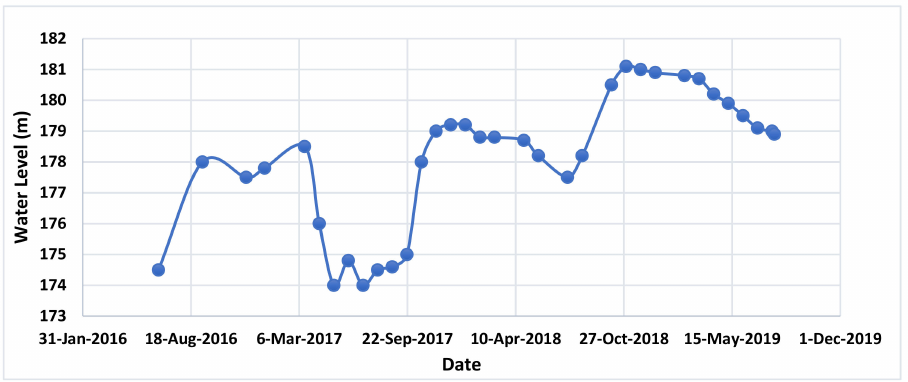
Figure 3. In situ water level of AHDL between 2016–2019 obtained from (NRI) [32]. The moderate spatial resolution is useful for our study area to achieve full coverage of the AHDL in the same swath and relatively manageable memory occupation. The moderate spatial resolution is compensated for by a high radiometric performance for both instruments in terms of noise and quantization error [36], which is fundamental for experimenting on the retrieval of depth from optical measurements. In particular, we used the reflectance of green, red, and NIR bands for both SLSTR and OLCI instruments to estimate the lake’s depth. (Table 1) shows the main specifications of the two instruments, and (Table 2) lists the spectral bands used in this paper